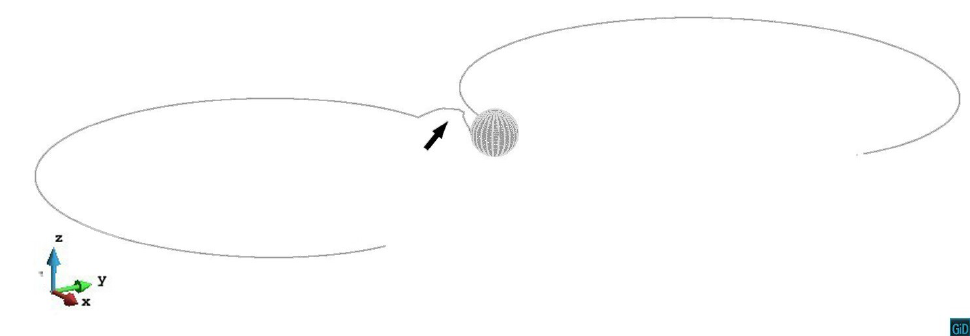
Figure 20. Snapshot of the dislocation cross-slip (black arrow) on the z / R = − 0.2 plane. The plastic strain ε = 2.28 × 10 − 4 .